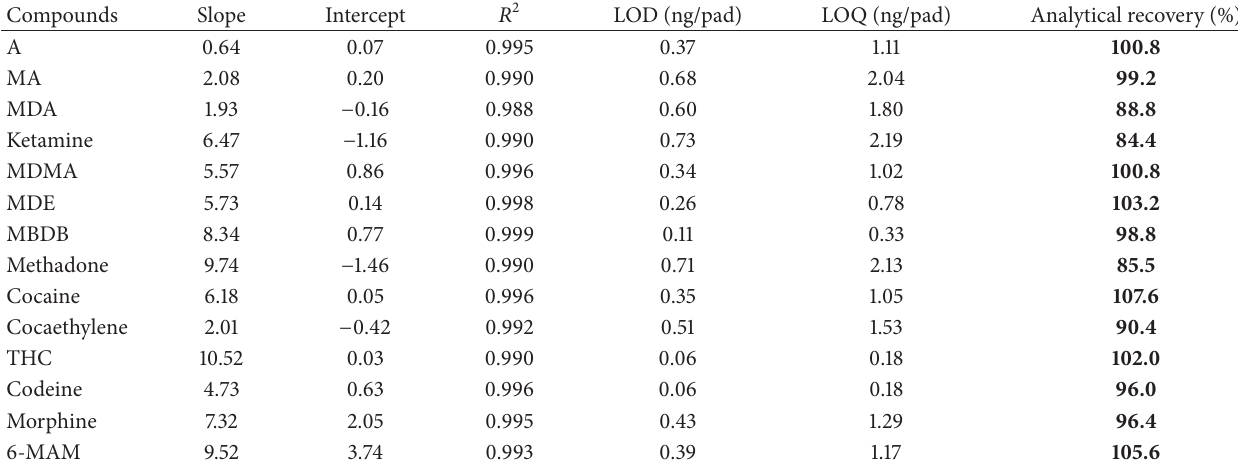
Table 2: Linearity of the HS-SPME-GC-MS procedure for compounds under